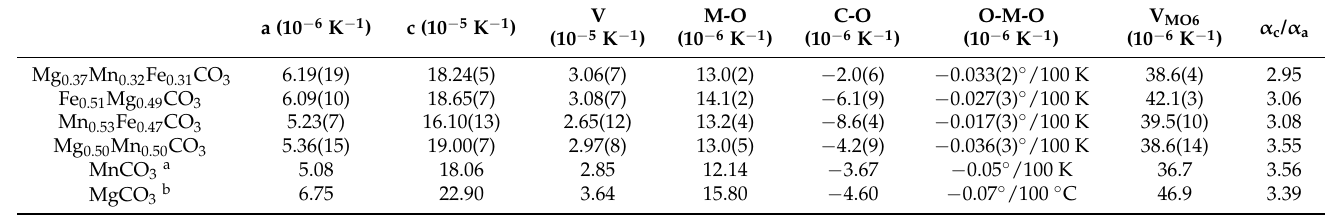
Figure 2. The variations of lattice parameters in MFM, MF, FM, and MM at the different temperatures. Table 1. Thermal expansion coefficient of calcite-type ACO 3 carbonates at ambient pressure.